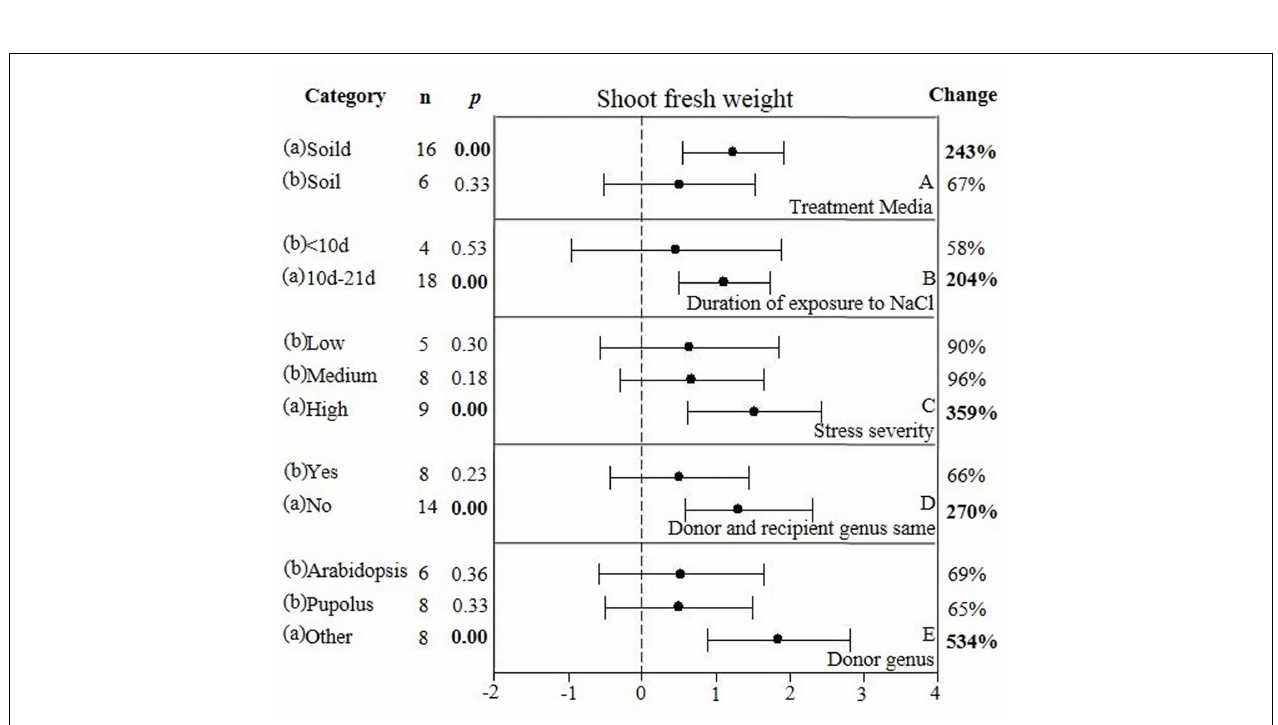
FIGURE 6 | Weighted summary effect sizes (ln R ) and 95% CIs showing how moderator variables affect the extent to which CBL transformation modifies seed germination. (A) Stress severity, (B) Duration of exposure to NaCl, (C) Donor and recipient genus same, and (D) Donor genus. A p ≤ 0.05 indicates that the moderator level was significantly different than zero; n stands for the number of studies.